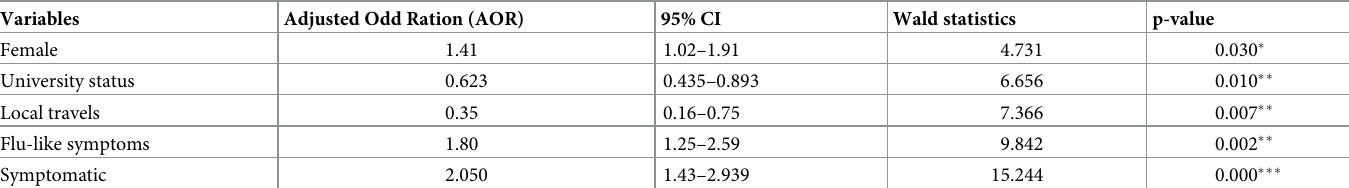
Table 4. Predictors of COVID infection among the university